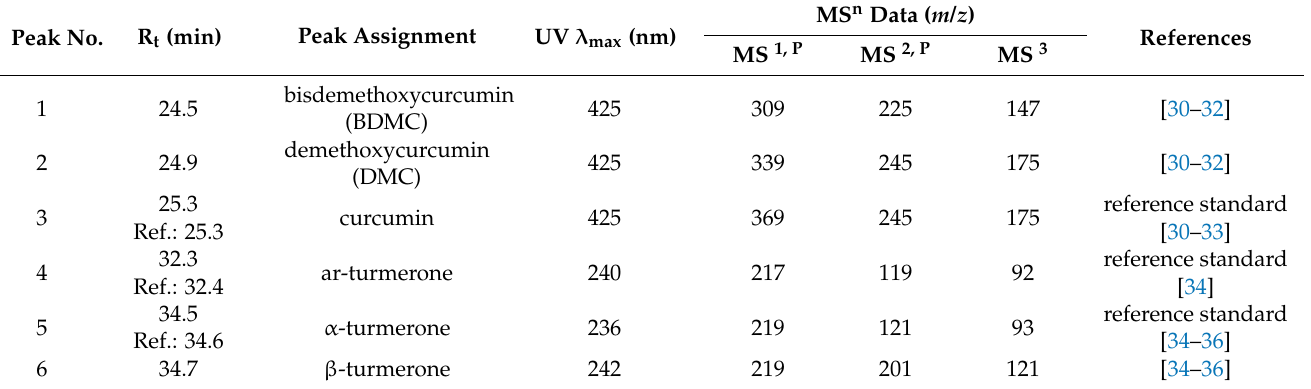
Table 3. Retention times (R t ), UV- and mass spectrometric data of active substances of turmeric. Only the most intense m / z ratios of fragment ions are displayed ( P precursor